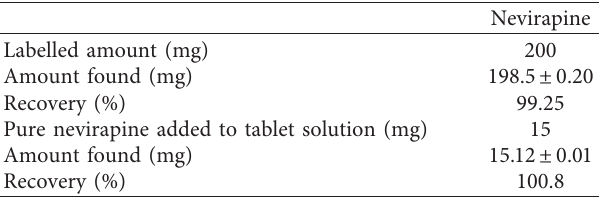
Table 4: Results of analysis of nevirapine in pharmaceutical for- mulations by the DPV